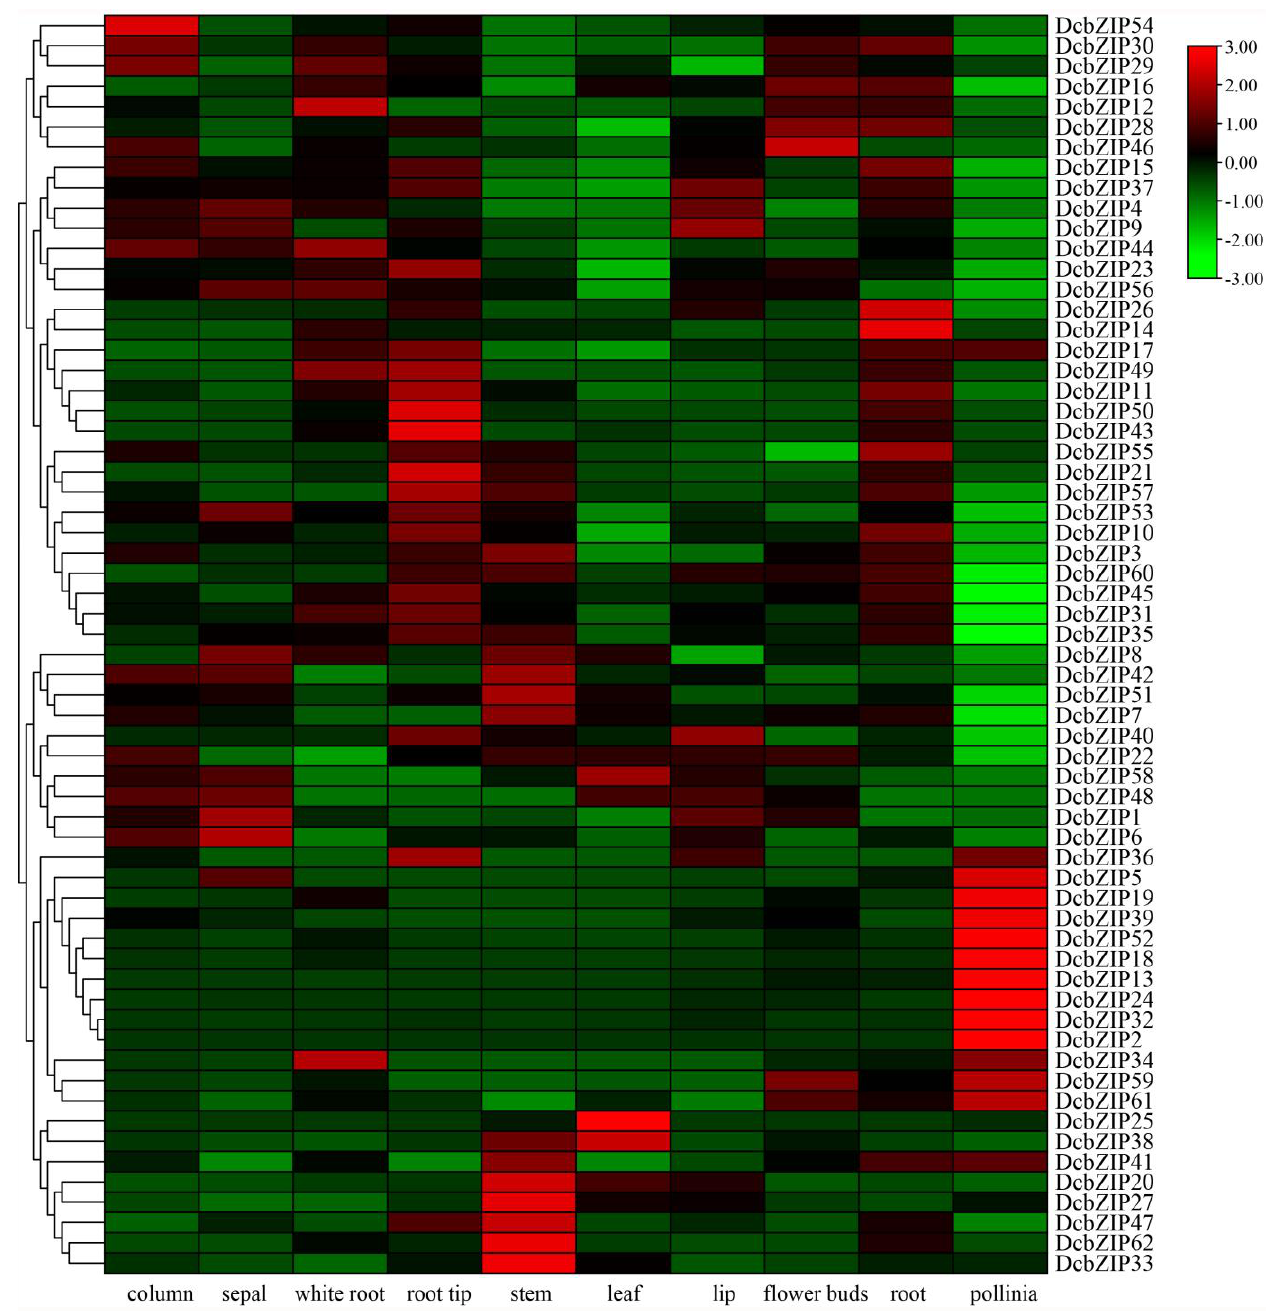
Figure 4. Hierarchical clustering of DcbZIP genes expression profiles across different D. catenatum tissues. Data were normalized relative to each gene’s mean expression value across all tissues and log2−transformed. TPM (transcripts per million) values were used to create heat maps showing the expressions of DcbZIP genes in different tissues. The expression level ranges from low expression (green) to high expression (red).